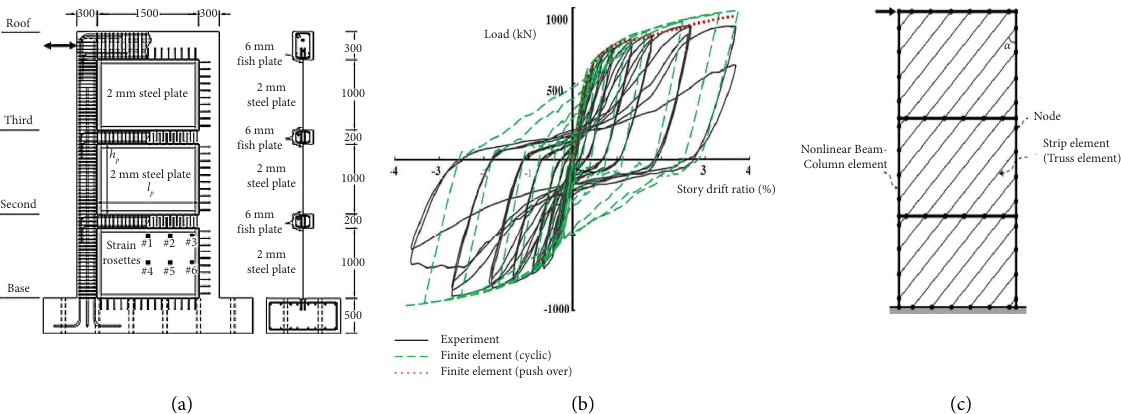
Figure 2: Numerical model validation. (a) Geometric and reinforcing details of the RCF with SPSW [28], (b) hysteresis curve of numerical model [29] and Choi and Park laboratory sample [28], (c) fnite element model double-sided diagonal truss element in the cyclic analysis